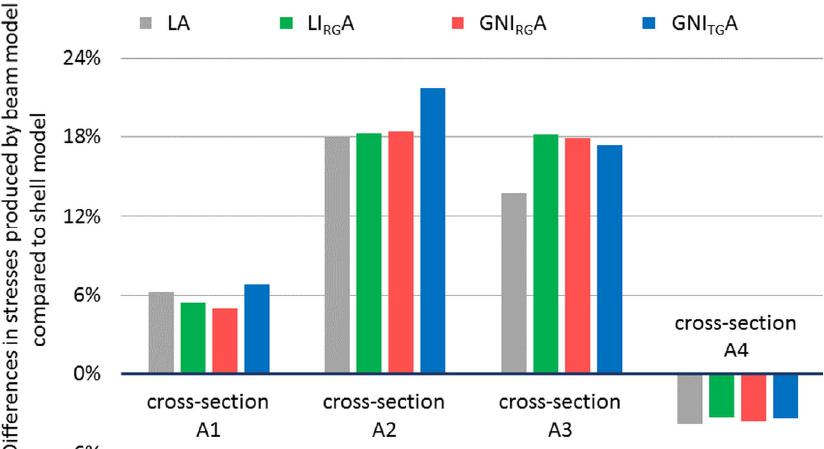
Figure 11. Percentage differences in the stresses produced by the common “beam” model in the SCIA Engineer compared to the more complex “shell” model in ADINA.